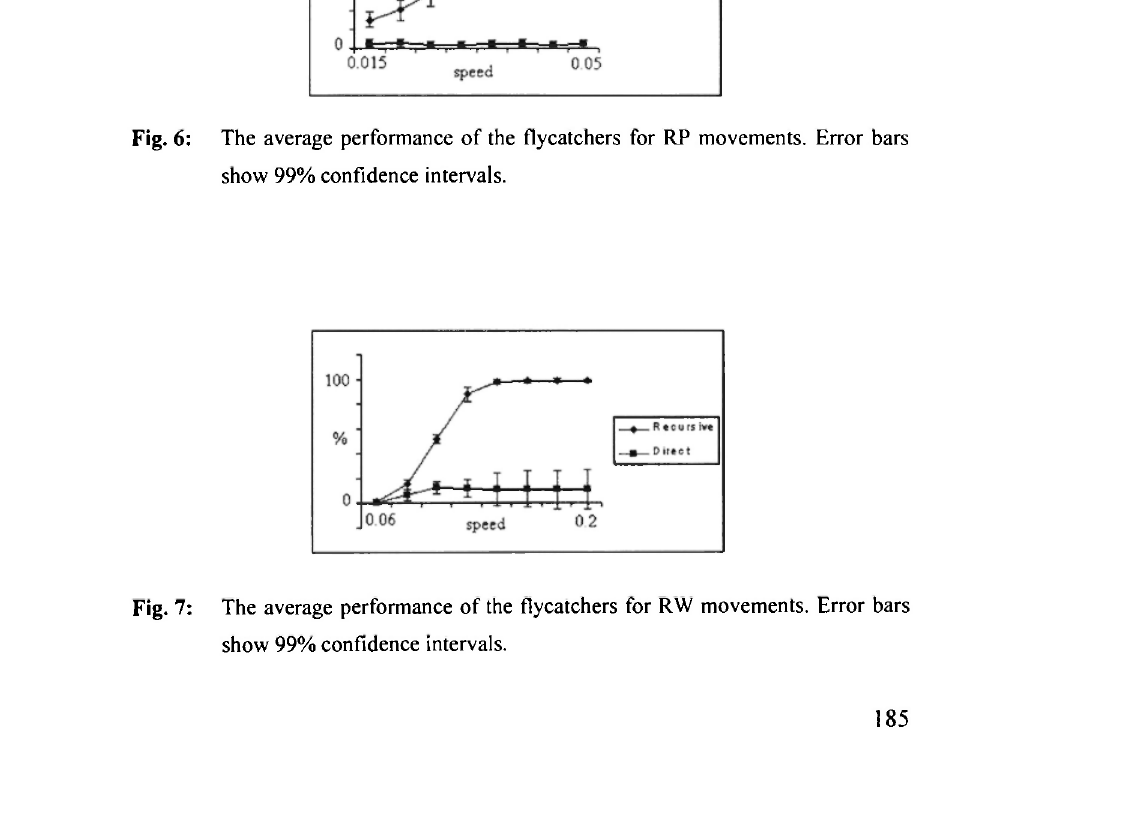
Fig. 7: The average performance of the flycatchers for RW movements. Error bars show 99% confidence intervals.